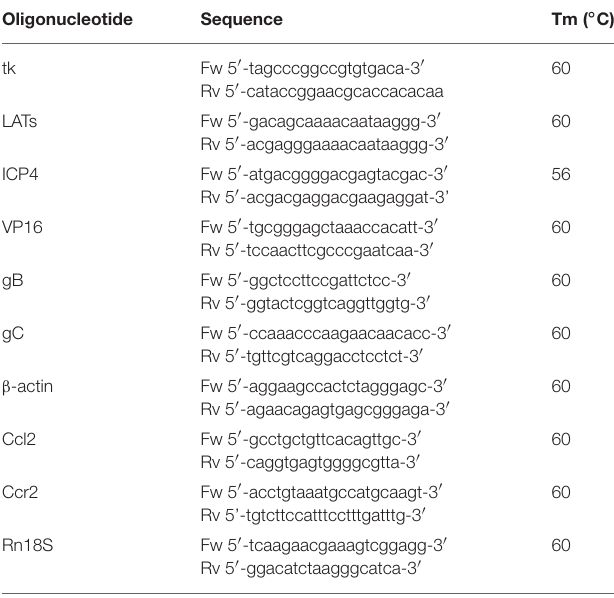
TABLE 2 | Oligonucleotides and PCR conditions.